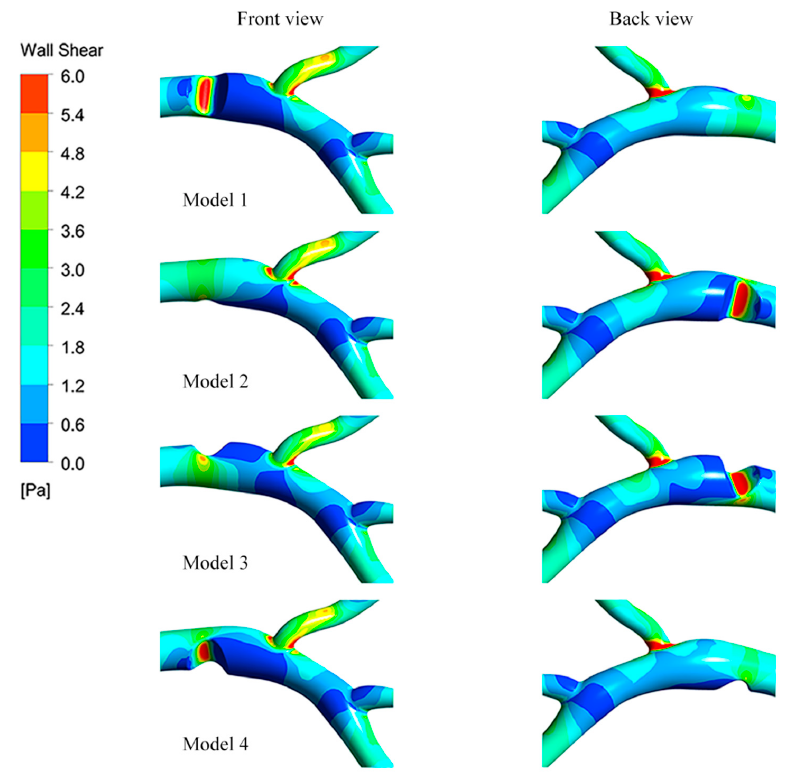
Figure 10. Cloud map of the WSS distribution during the peak systolic period. At the shoulder of the LCX bifurcation, that is, point 1, the variation trend of the WSS under different models was similar, but the WSS value was different. The WSS values were sorted from high to low; the highest were model 2 and model 4, and their WSS changes were almost the same; the second was model 1; the lowest was model 3, which was significantly different from the other models. At the apex of the LCX bifurcation, that is, point 2, the trend of the WSS changes was similar to that at point 1. The difference was that the amplitude of the WSS was larger here, and the maximum amplitudes from model 1 to model 4 were 26.54 Pa, 22.79 Pa, 37.36 Pa, and 21.84 Pa, respectively. In addition, no matter which model, the WSS at point 2 was the largest among the four points, which was caused by the impingement and shunting of blood here. At the front-end side branch of LAD, namely point 3, the WSS fluctuation was significantly stronger than in the other models, but the WSS value at this point was the smallest among the four feature points. Here, the low and oscillatory WSS was due to the combination of plaque, eddy currents, and shunts that the blood experienced before entering the site. At the shoulder of the DB bifurcation, that is, point 4, the WSS trend of each model was similar, and there was only a slight fluctuation in the time period of 2.1 s to 2.2 s. It is not difficult to observe the